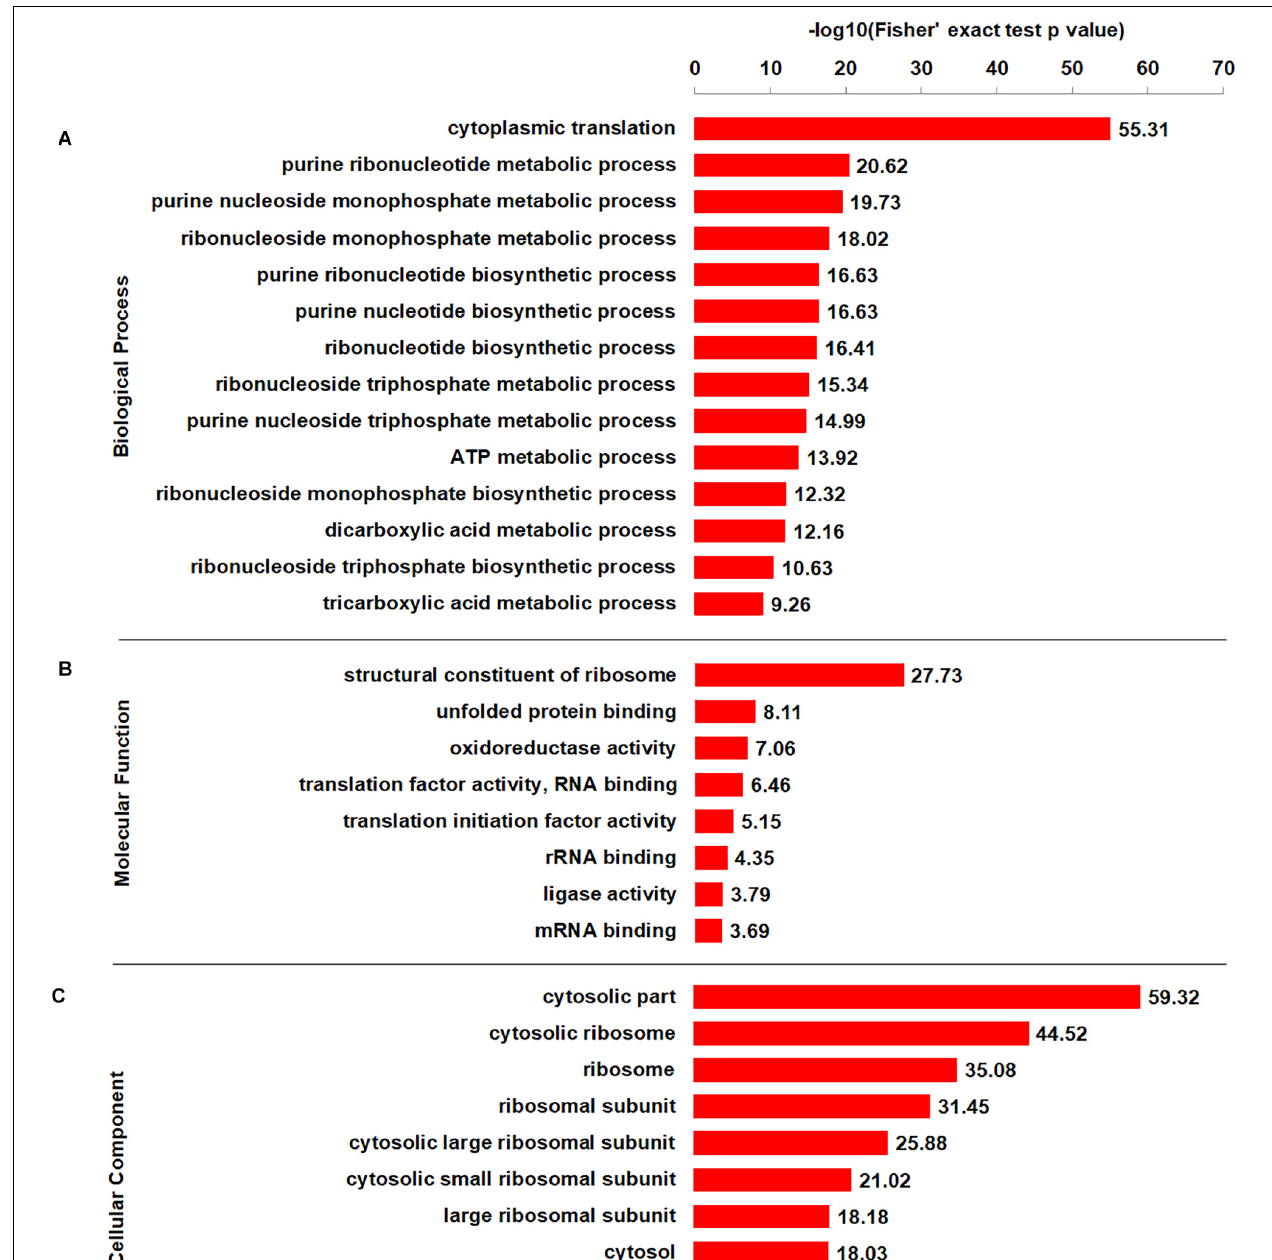
FIGURE 4 | GO-based enrichment analysis of crotonylated proteins according to biological process (A) , molecular function (B) , and cellular component (C) .